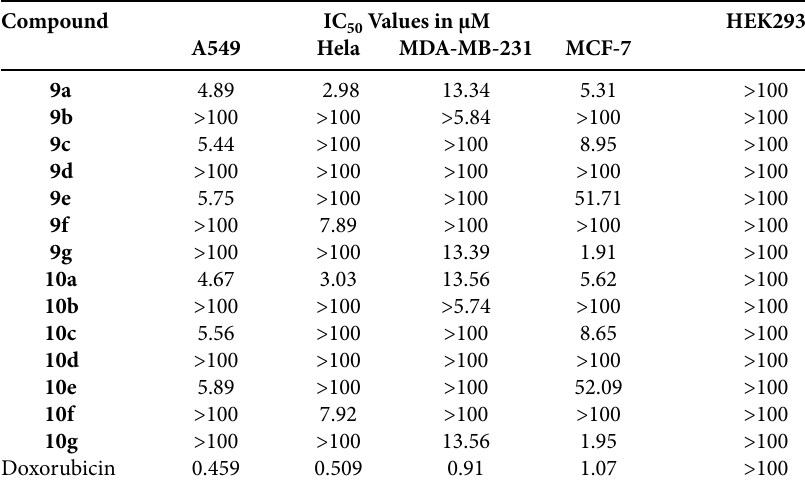
Table 2. IC 50 values of tested compounds 9a–g and 10a–g against four human cell lines and nor- mal cell line (HEK